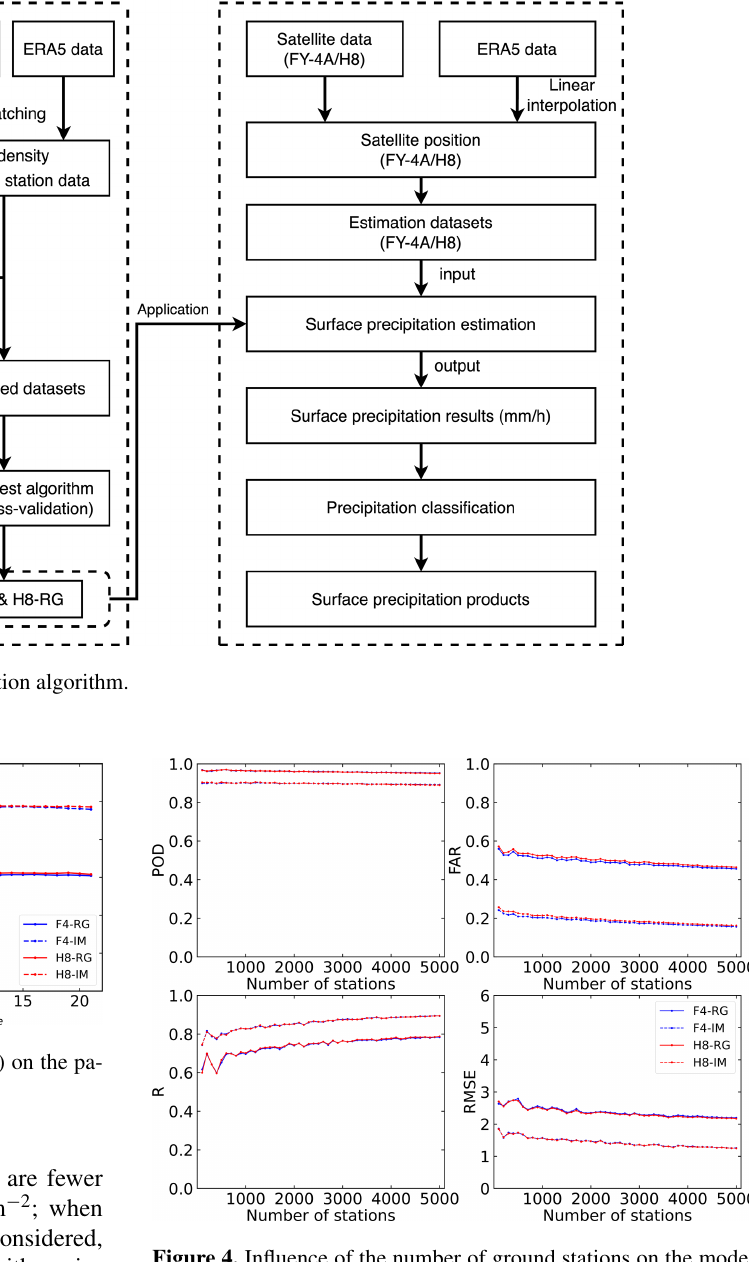
Figure 4. Influence of the number of ground stations on the model training